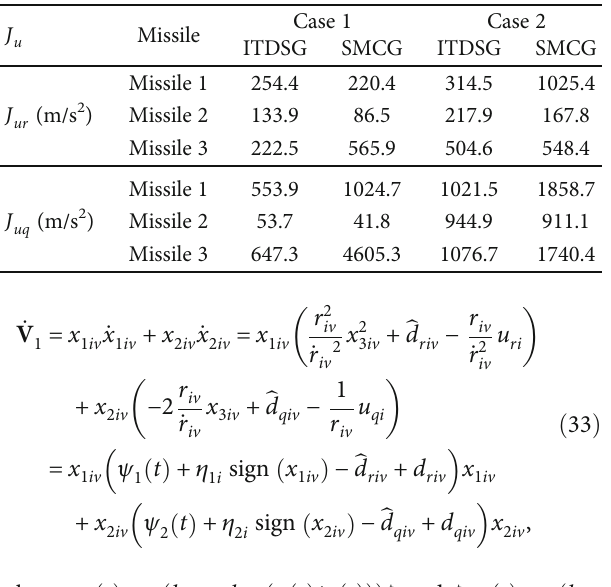
(f) Accelerations on the normal LOS direction Figure 7: Simulation curves for a constant velocity target. Table 2: Energy